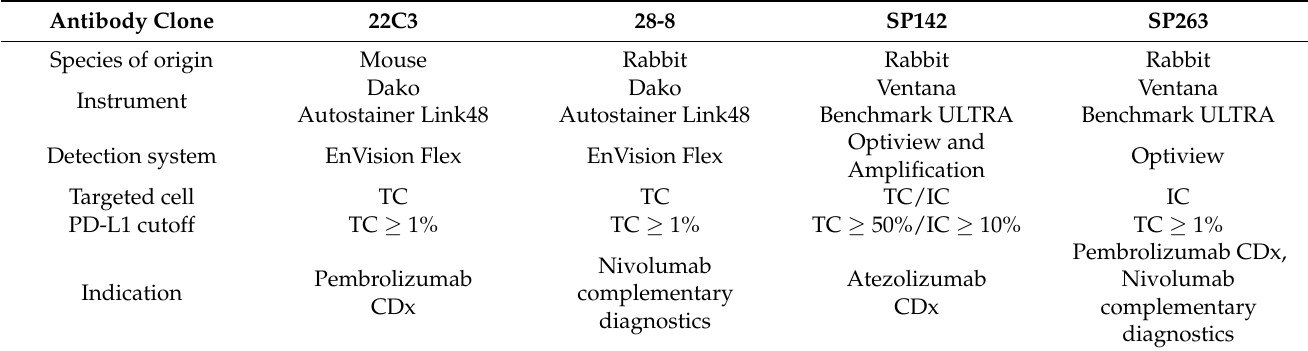
Table 4. Summary of PD-L1 immunohistochemistry assays in non-small cell lung cancer (NSCLC). Antibody